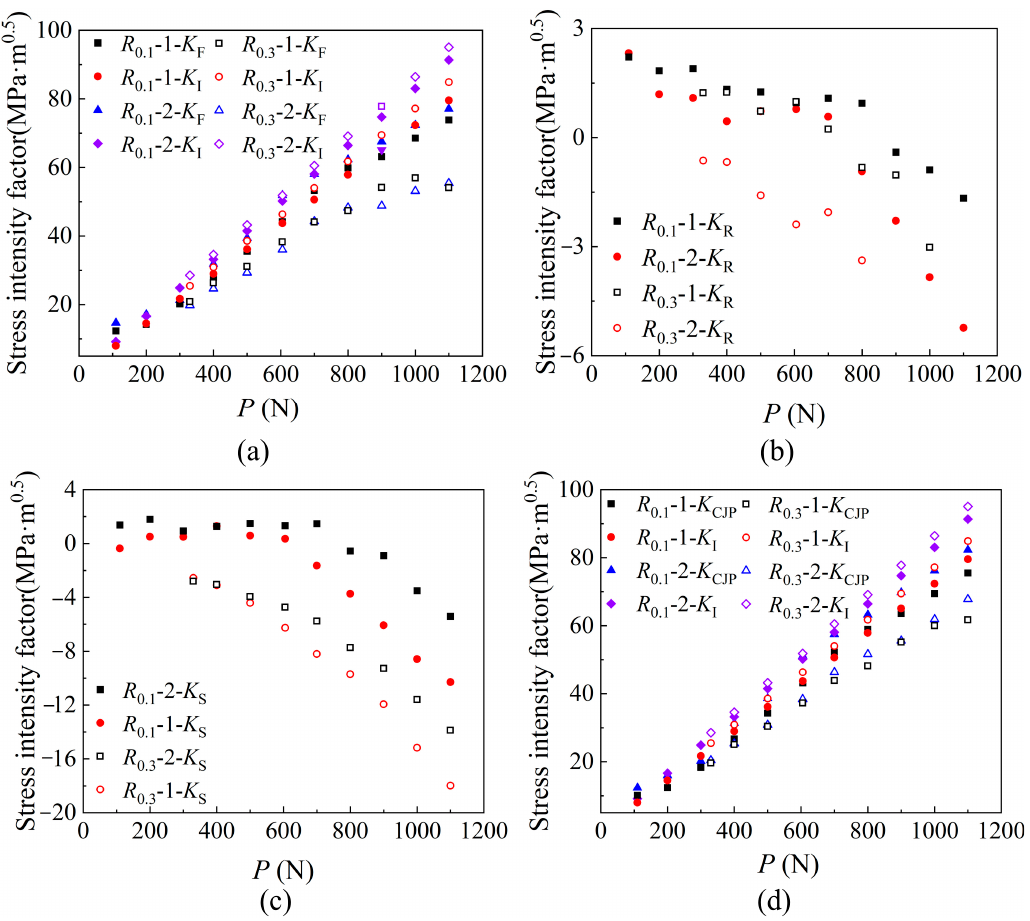
Figure 12. SIF of ( a ) K F , ( b ) K R , ( c ) K S , and ( d ) K CJP change with load P (In the legend, 1 and 2 represent di ff erent crack lengths, respectively. Under the condition of R = 0.1, 1 and 2 represent crack lengths of 32.756 mm and 33.940 mm, respectively. Under the condition of R = 0.3, 1 and 2 represent crack lengths of 32.037 mm and 33.513 mm, respectively.).